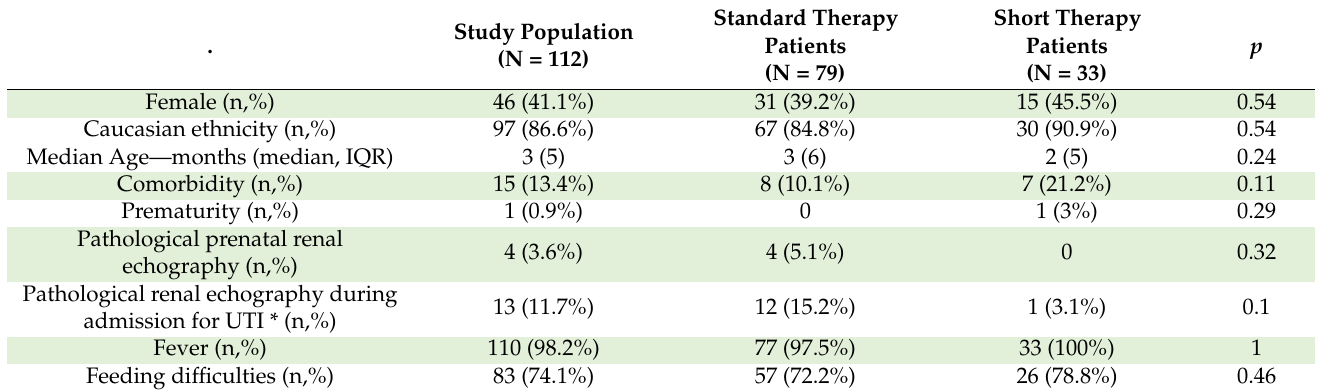
Table 1. Clinical information and demographics of the study